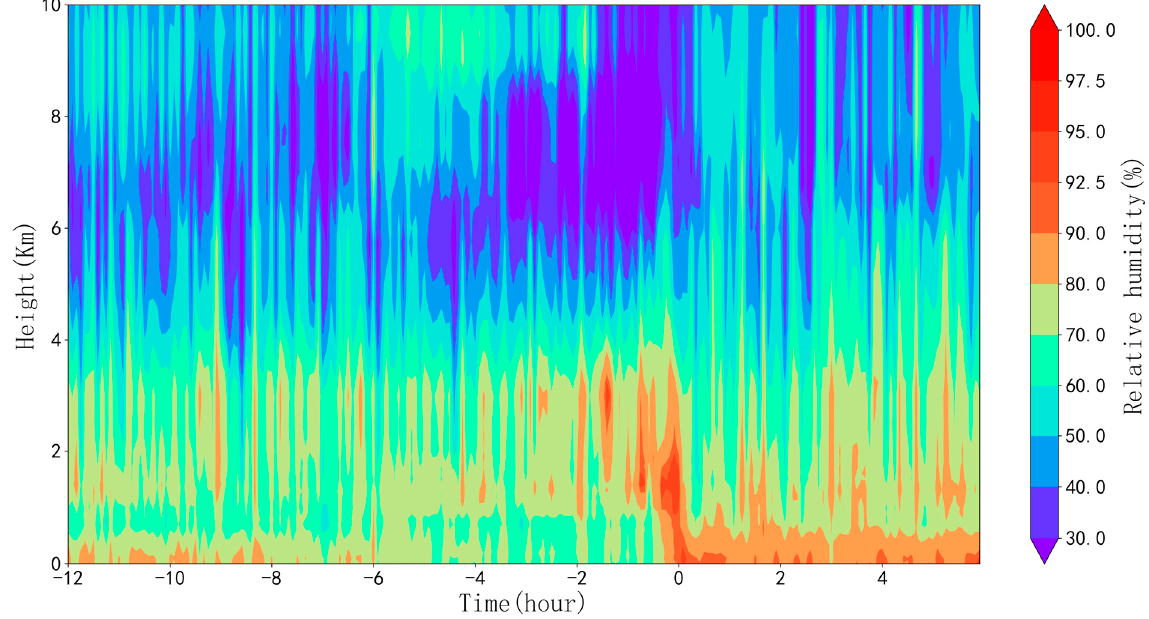
Figure 2. Vertical distributions of relative humidity during 12 h before and 6 h after the start of LRs in 2021.